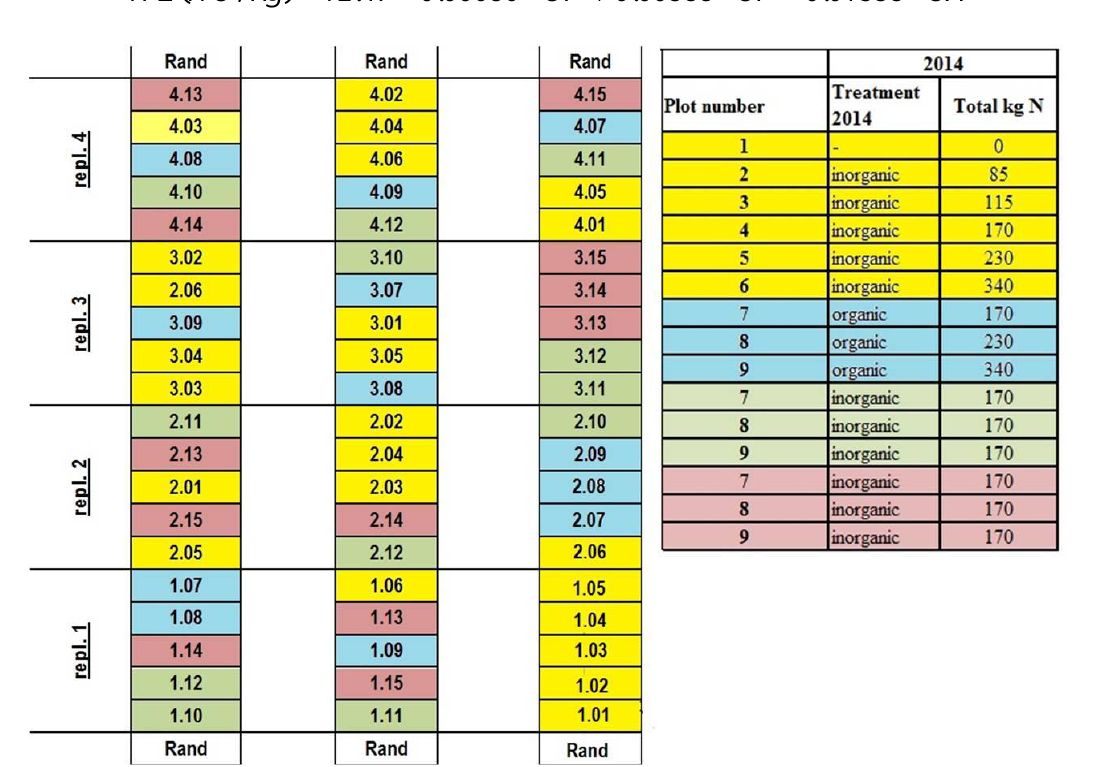
Figure 2. Map of different types and levels of fertilization applied on the experimental grassland plots. The 60 plots were split into four groups of 15 plots and for every group the treatments were applied as indicated in the table. The black line is a measurement rail which is also shown in Figure